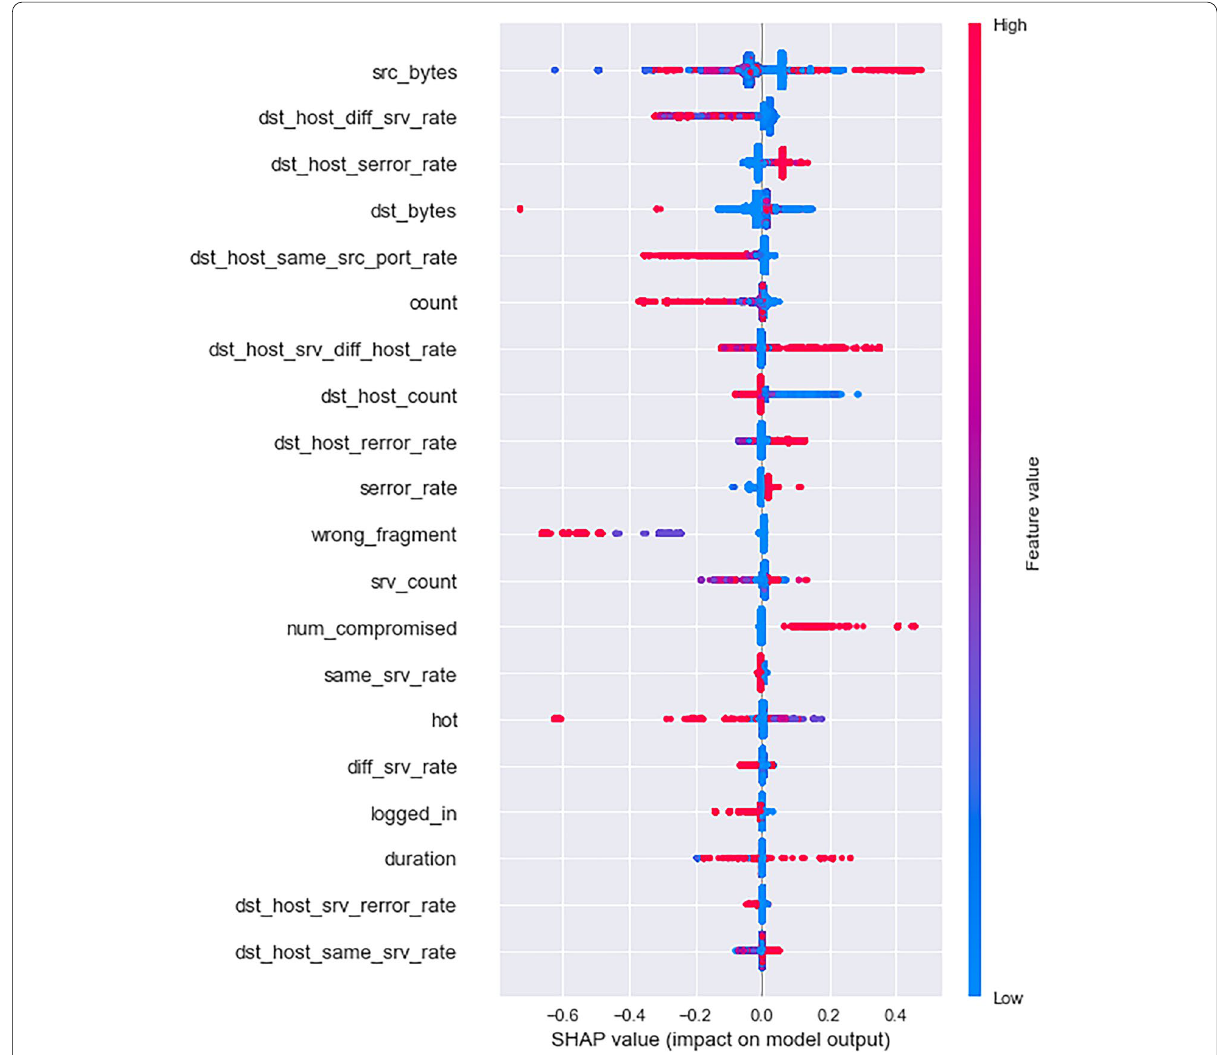
Fig. 8 Global feature independent variable SHAP